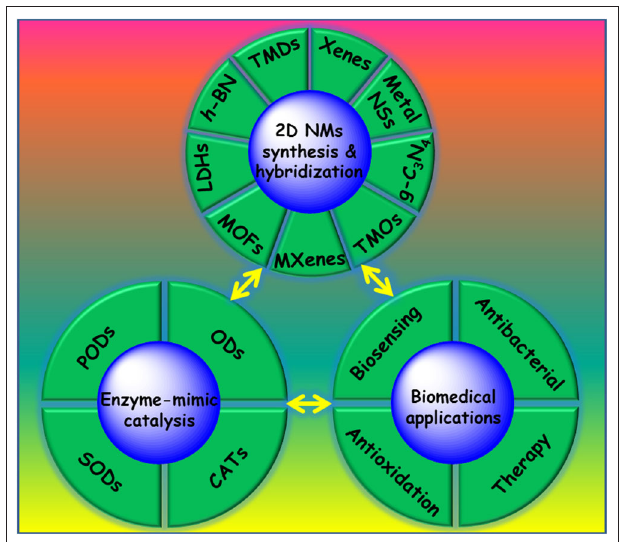
FIGURE 1 | Two-dimensional NMs with enzyme-like activities for biomedical applications.